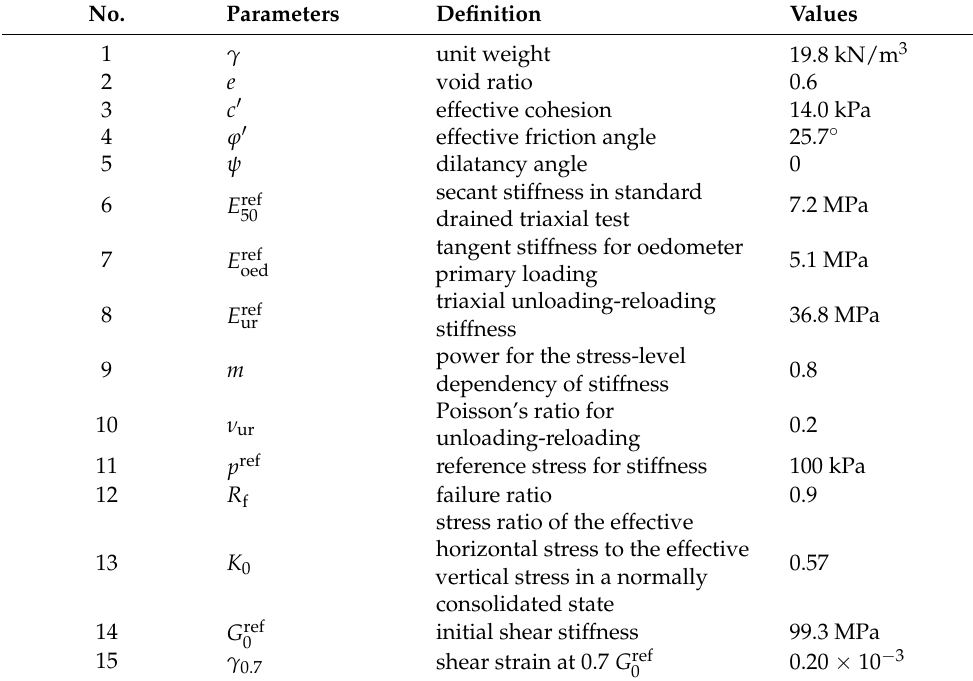
Table 1. Physical and mechanical parameters of the HSS model for the soil